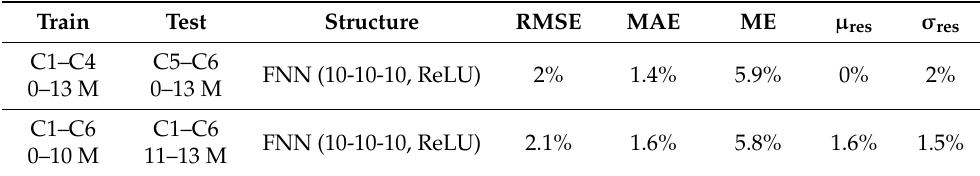
Table 5. Test results with impedance measurements at 50%